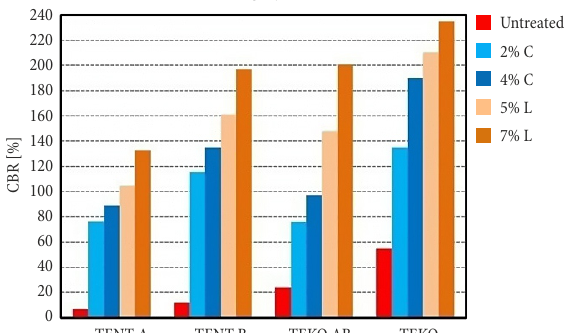
Fig. 6. CBR values of tested materials after 28 days